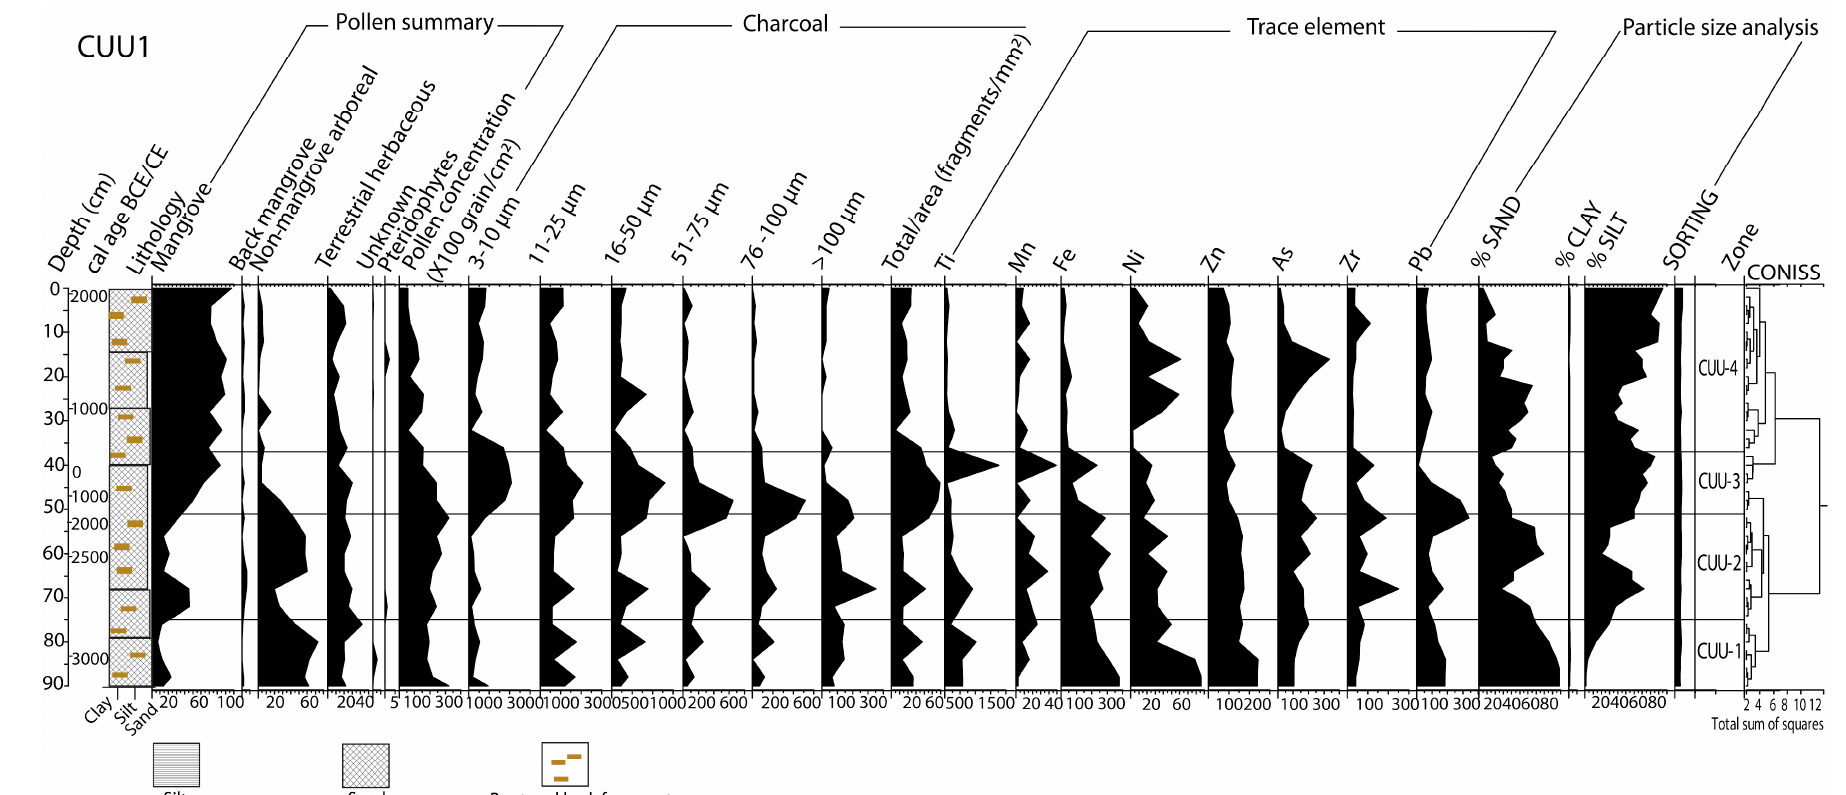
Figure 9. Frequency plot showing pollen summary, charcoal, trace elements and particle size data from CUU1 core. Zonation is based on a cluster analysis of pollen data.